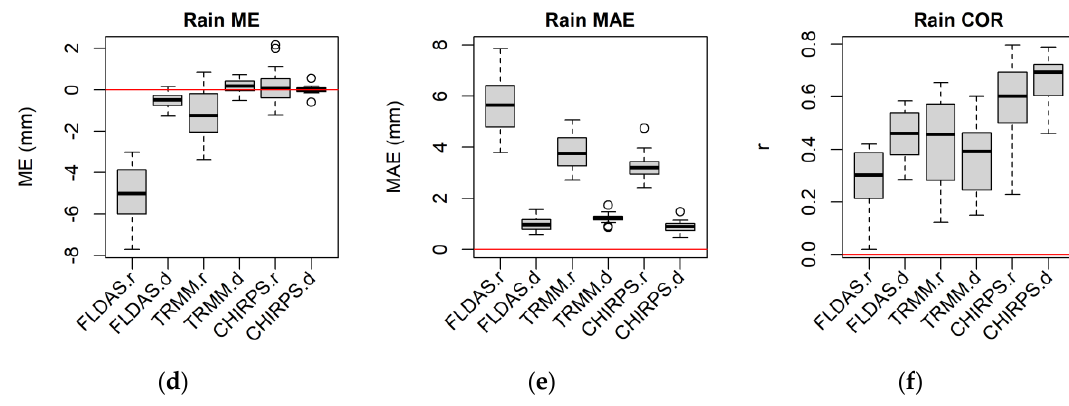
Figure 14. Pixel-level satellite/interpolated temperature ( a – c ) and rainfall ( d – f ) seasonal data (seasonal averages from daily data) accuracy statistics box plots over 22 meteorological stations distributed in Amhara Region, Ethiopia for 2003–2016. The “.r” is for rainy and “.d” is for dry seasons.